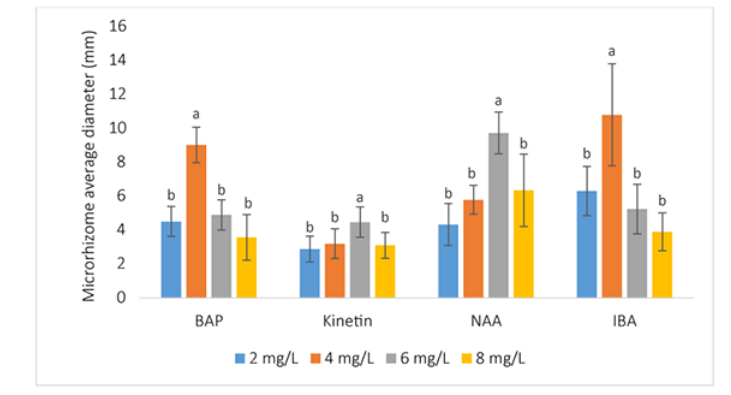
Figure 3 Effect of plant growth regulators (PGRs) on microrhizome diameter [mean ± t (29) × SE , where t (29) is the upper 0.025 critical value for the t distribution with 29 degrees of freedom]. Microrhizome diameter also had the same tendency as fresh weight since the bell-shaped dose-respond curves were formed when the concentrations of PGRs increased, with the four peaks of 9.03 mm, 4.47 mm, 9.73 mm, and 10.80 mm at the concentrations of 4 mg/L BAP (6-benzylamino purine), 6 mg/L kinetin, 6 mg/L NAA ( α - naphthaleneacetic acid), and 4 mg/L IBA (indole-3-butyric acid), respectively (within a group, means having a letter in common are not significantly different at the 5% level by Duncan’s